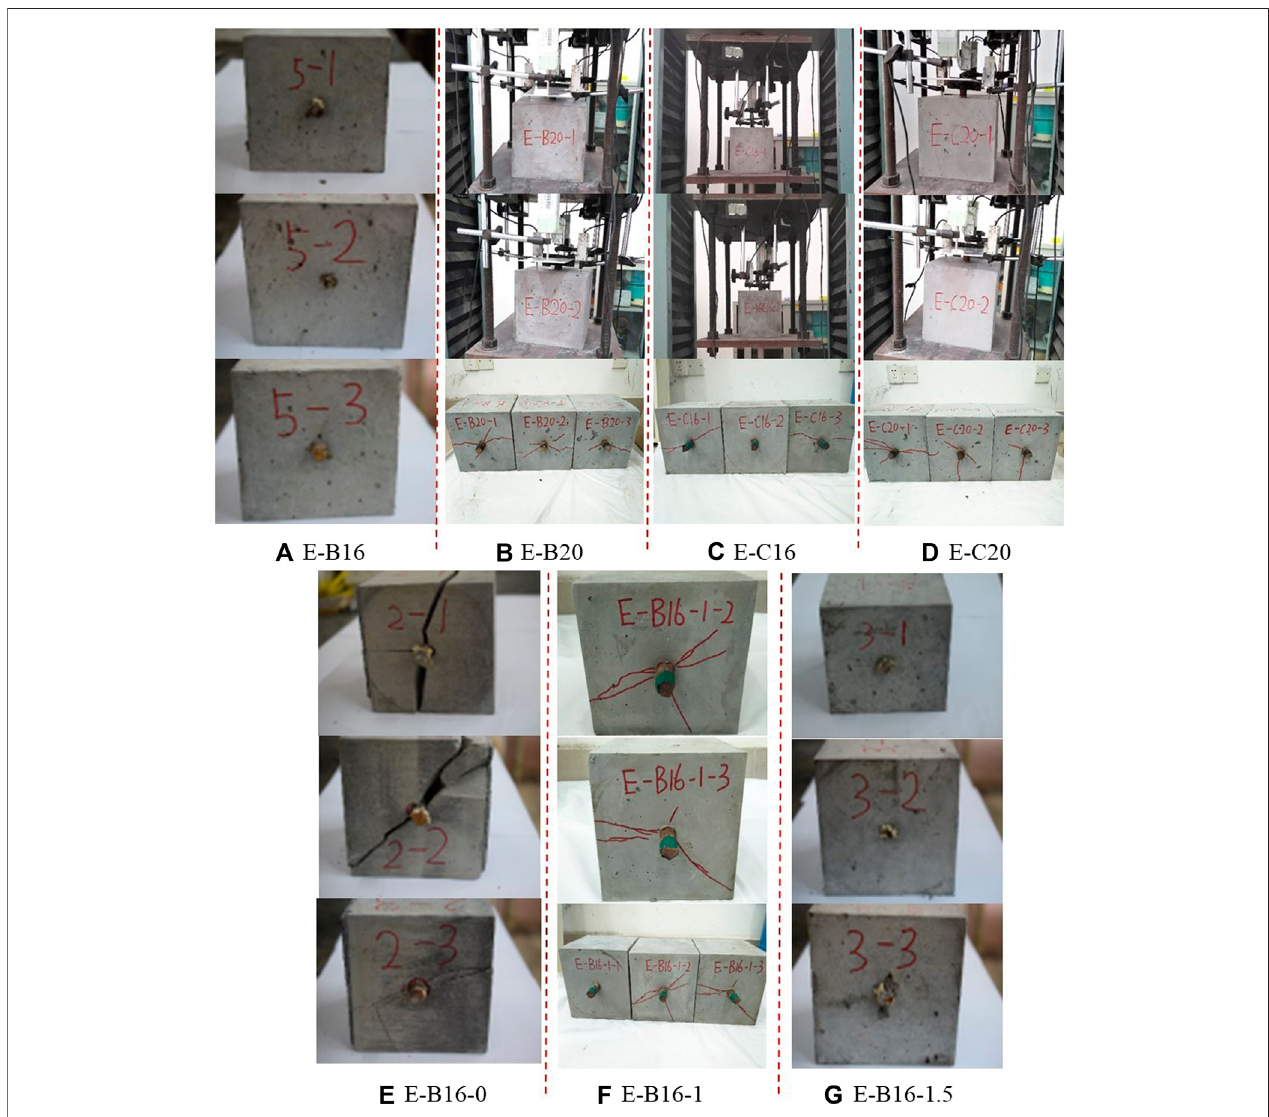
FIGURE 7 | Typical failure